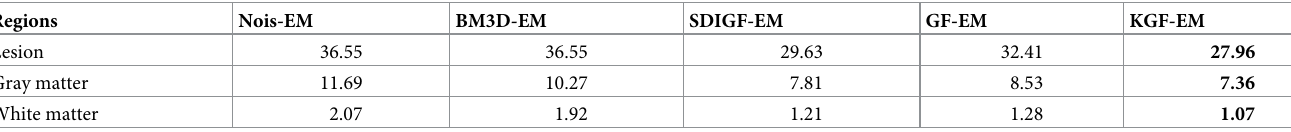
Table 2. MAEs of KEM reconstructed images from noisy and denoised sinogram datasets.